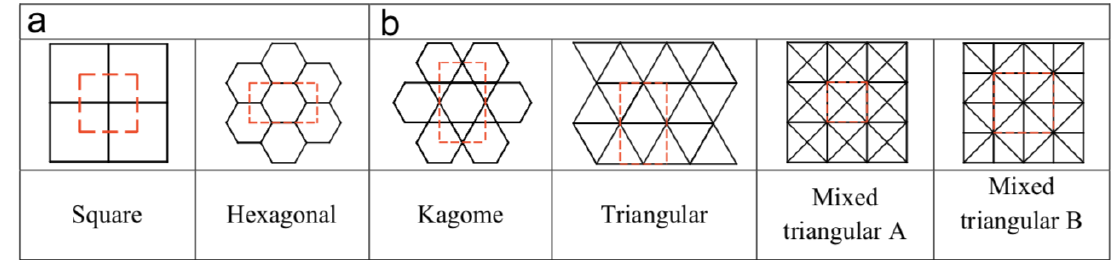
Figure 4. ( a ) Bending dominated lattices ( b ) Stretching dominated lattices [11].